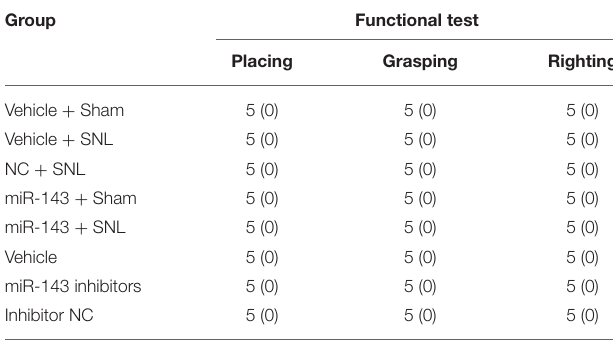
TABLE 2 | Mean ( SD ) changes in locomotor function.